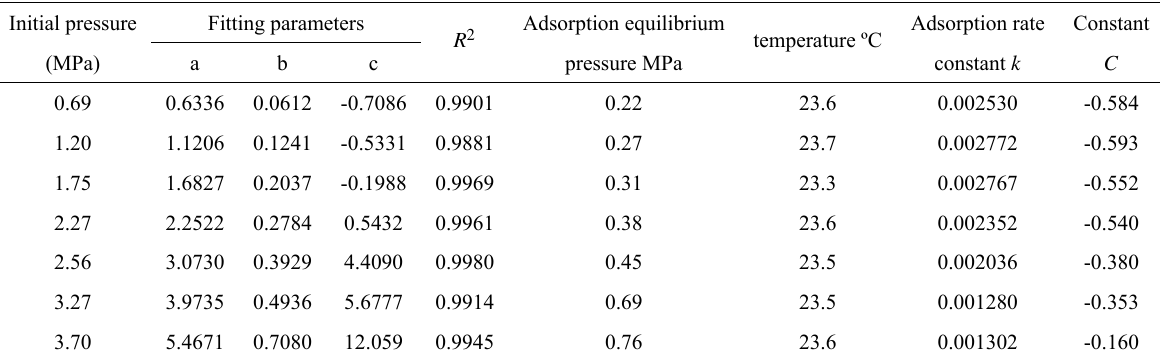
Adsorption rate constants for coal with 0.898% moisture content.